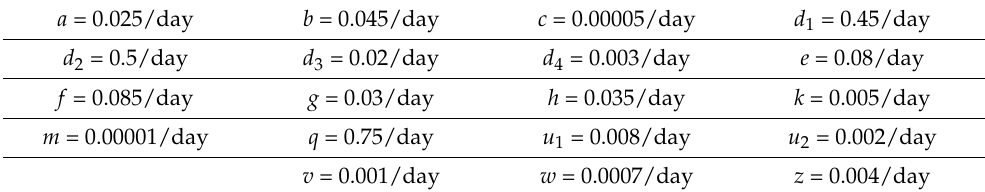
Table 1. Model parameter values.